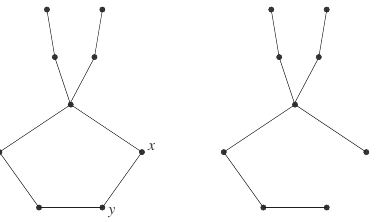
Figure 1. A l -Generalized Quasi Tree or a l -Apex